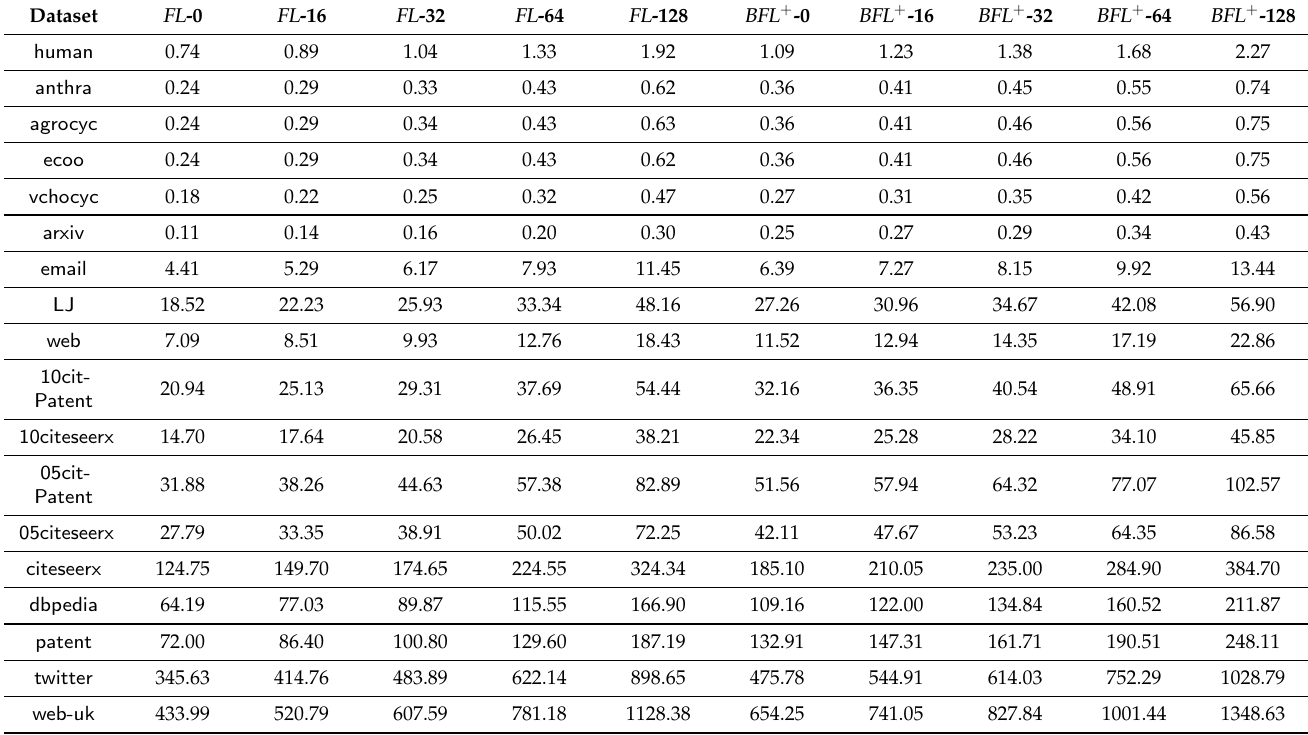
Figure 6. Operational time of different algorithms for RR computation (ms). Table 4. Comparison of the index size